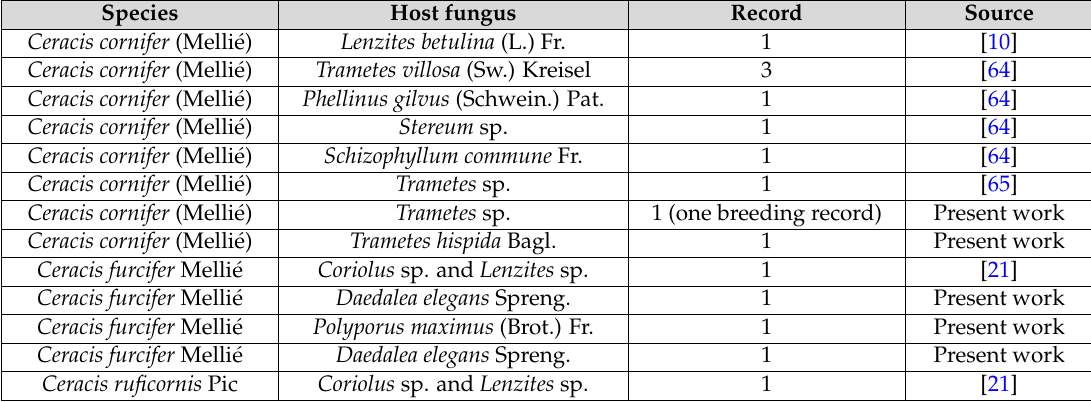
Table A2. Other host fungi of the furcifer